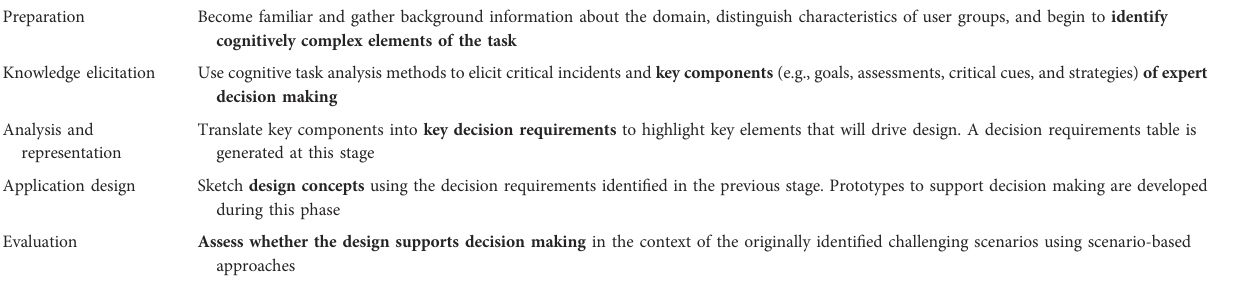
TABLE 1 Description of stages in decision centered design